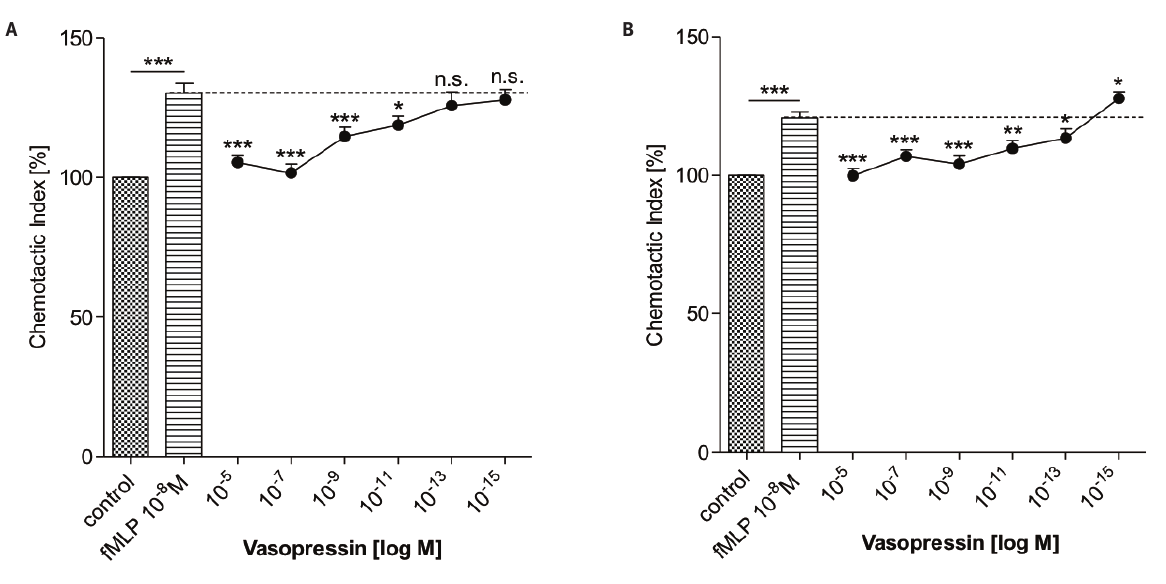
Figure 2: Priming cells with different concentrations of AVP PMNs (A) and monocytes (B) were pre-incubated with different concentrations of AVP for 30 min and migrated against fMLP [10-8 M]. Migration towards medium served as the negative control, as positive control, migration against fMLP [10-8 M]. Statistical analyses: Mann- Whitney U test [n.s., not significant, *, p<0.05, **, p<0.01, ***,